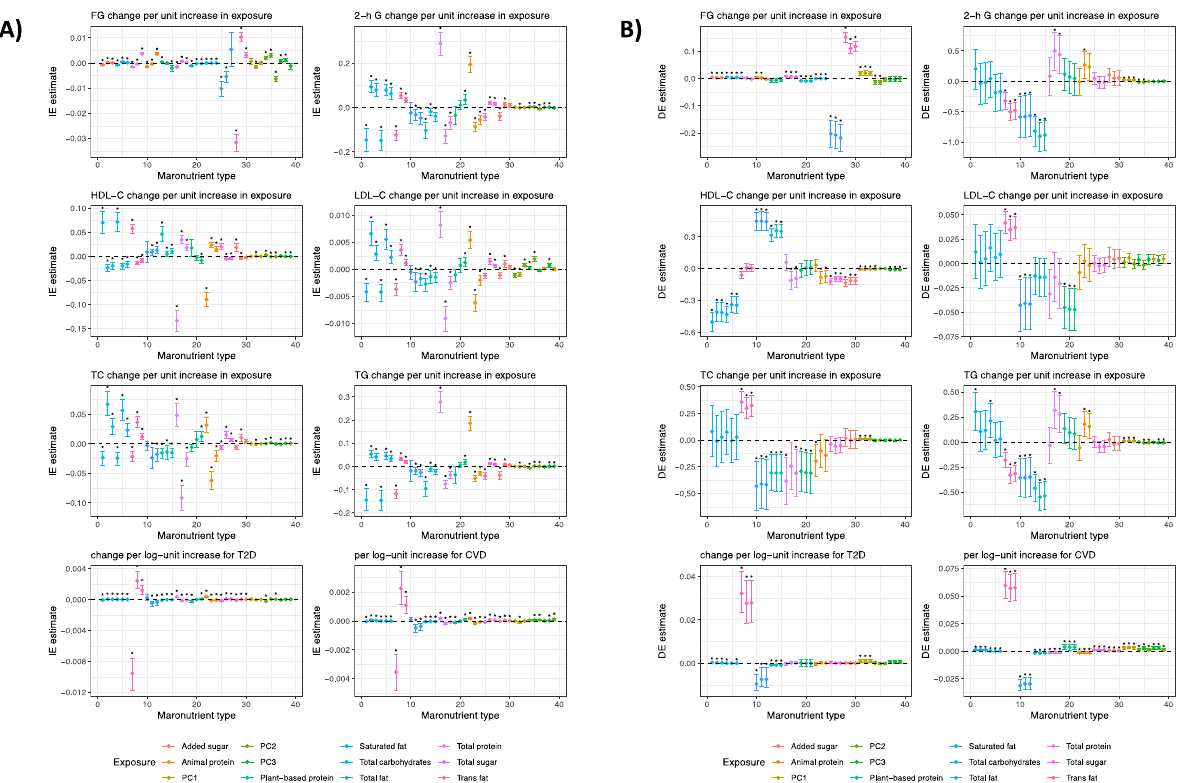
Figure 3. Direct and indirect estimates between macronutrients and outcome in pairwise mediation analysis with body mass index, 5-level physical activity and physical activity index as mediators. Macronutrients are organized on the x-axis in colour codes, ordered consecutively (from left to right) for body mass index, 5-level physical activity and physical activity index. Data are presented as ( A ) indirect and ( B ) direct estimates and 95% confidence intervals; Indirect effect is the estimated average increase in the dependent variable as a result of the mediators; (*) significant after FDR correction at p < 0.05; HDL-C, LDL-C: high- and low-density lipoprotein, respectively; TC: